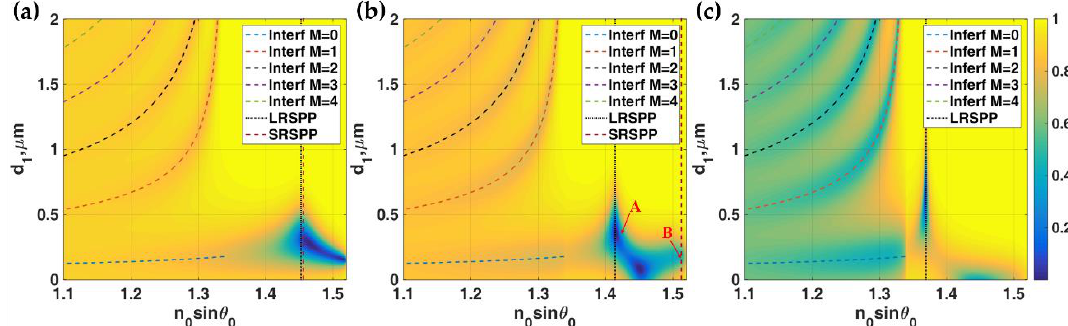
Figure 3. Responses showed | r p | 2 for λ = 633 nm n 0 = 1.52, n 1 = 1.34 with thickness d 1 and n 2 = 0.18344 + 3.4332 i with thickness d 2 , n 3 = 1.34 ( a ) d 2 = 150 nm ( b ) d 2 = 60 nm and ( c ) d 2 = 30 nm. The colored curves shown in these figures were the interferometric mode positions calculated using Equation (3) and the two plasmonic modes calculated using Equation (2). ‘A’ and ‘B’ were labeled as plasmonic modes calculated using Equation (2). ‘C’, ‘D’ and ‘E’ are labelled as interferometric modes.